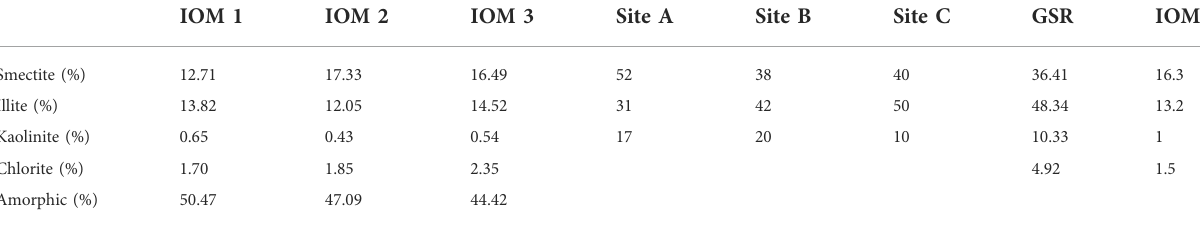
TABLE1Mineralgrouppercentagesindeep-seasediment:InterOceanMetaljointorganization(IOM)data(Zawadzkietal.,2020),GlobalSeaMineral Resources(GSR)data(GlobalSeaMineralResources,2018),SitesA-C(Bisschofetal.,1979).ItisworthnotingthatforIOM1,2,and3,claymineral percent is given relative to total sediment. Clay mineral percent is only relative to the sum of clay minerals at Sites A, B, C, and GSR.